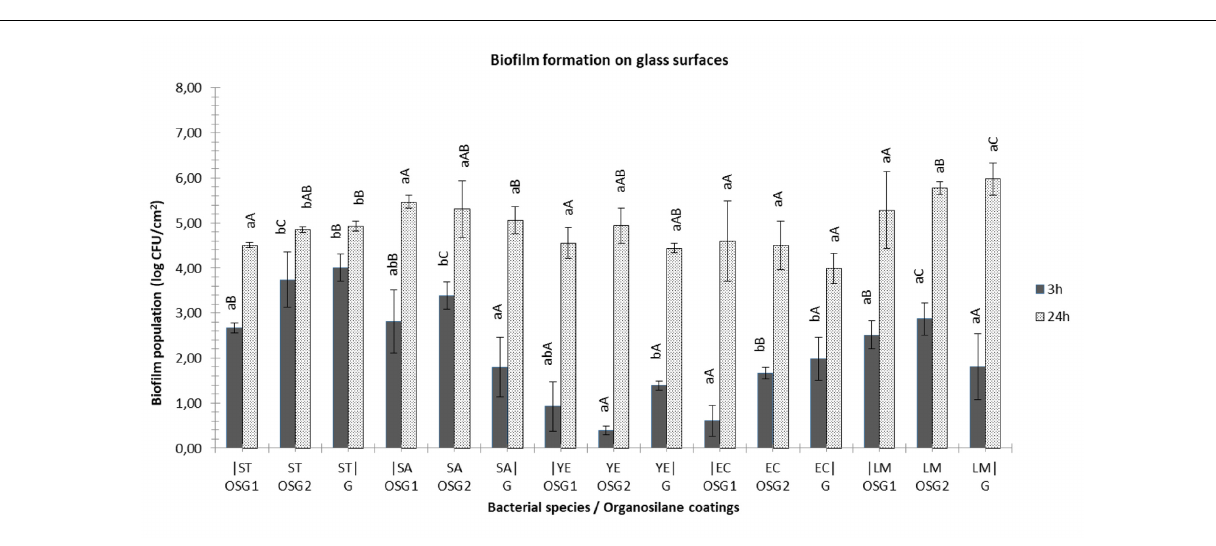
FIGURE 2 | Biofilm formation (log CFU/cm 2 ) on glass coupons with (OSG1/OSG2) or without (G) coating, using two strains of Salmonella Typhimurium (ST), Staphylococcus aureus (SA), Yersinia enterocolitica (YE), Escherichia coli (EC) or Listeria monocytogenes (LM) at 3 h (gray bars) and 24 h (white bars) of incubation at 37 ◦ C. Bars represent means ± standard deviations. Different lowercase letters indicate differences on cells attachment (3 h) or biofilm formation (24 h) according to coating for the same species. Similarly, different uppercase letters point out differences according to species adherence/biofilm formation for the same coated or